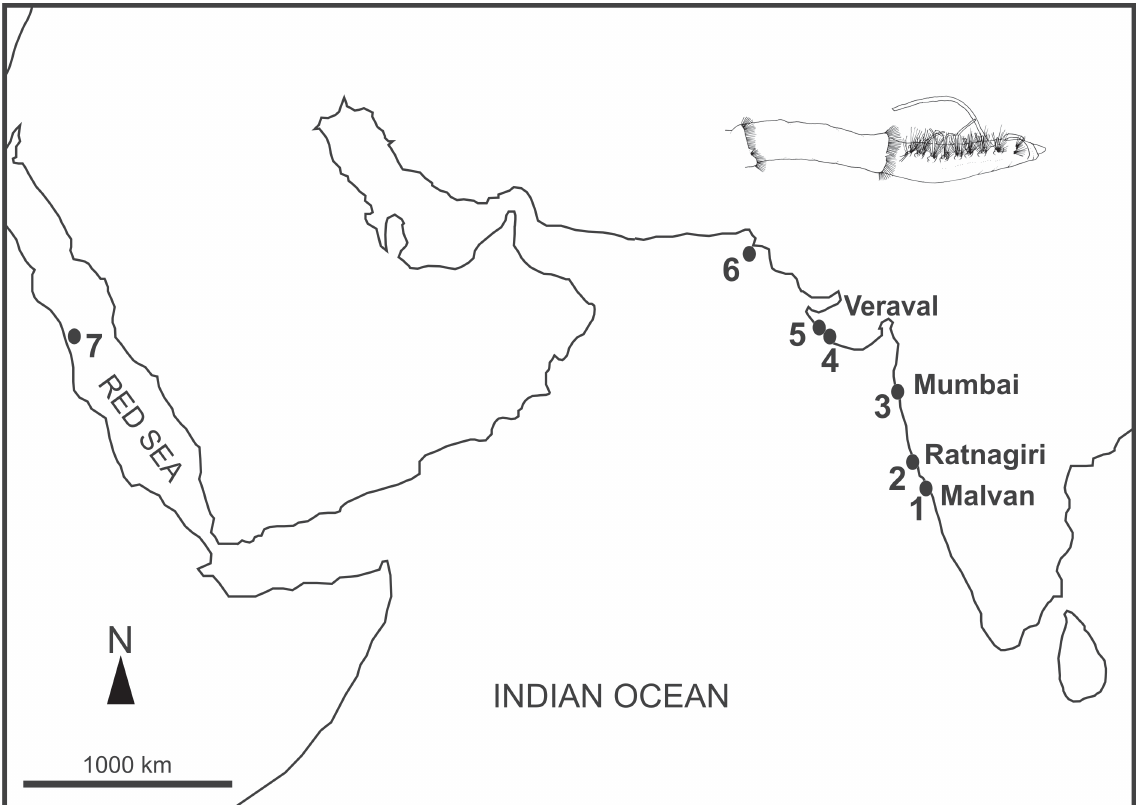
Fig. 1. Distribution of records of Heterospio around the Indian Ocean: Heterospio indica sp. nov. (present study) (1–4), H. longissima Ehlers, 1874 (data from Hartman 1974) (5–6) and H. longissima Ehlers, 1874 (data from Rosenfeldt 1989)